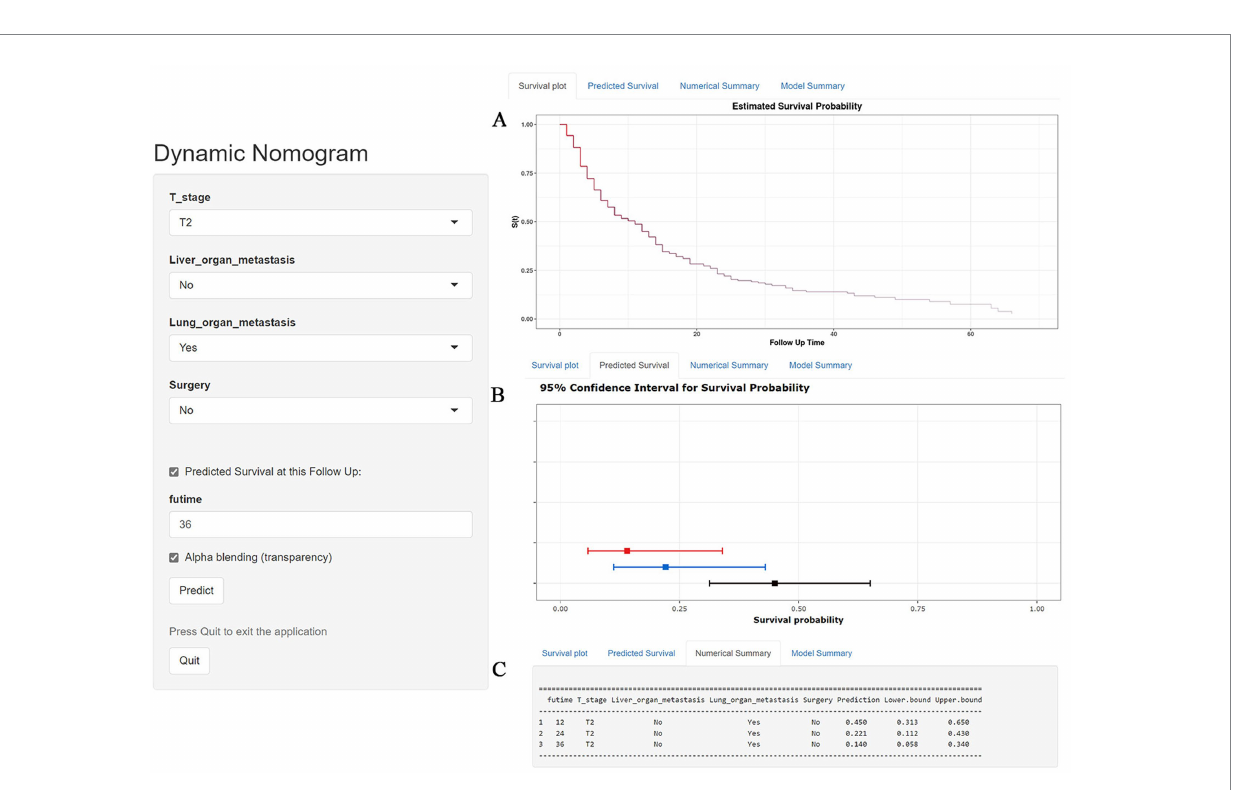
FIGURE 8 A web-based nomogram for predicting overall survival (OS) in an elderly kidney cancer with bone metastasis (KCBM) patient (T stage: T2, Liver metastasis: no, Lung metastasis: yes, Surgery: no). (A) The curve of the estimated probability of OS for this patient over time. (B) 95% confidence intervals of the 12-, 24-, and 36-month OS probabilities for this patient. (C) Numerical summary of the 12-, 24-, and 36-month OS probabilities for this patient. Due to a large number of visitors to the webpage, if the application cannot be used normally, please click “Quilt” or “Reload” in the lower-left corner to try